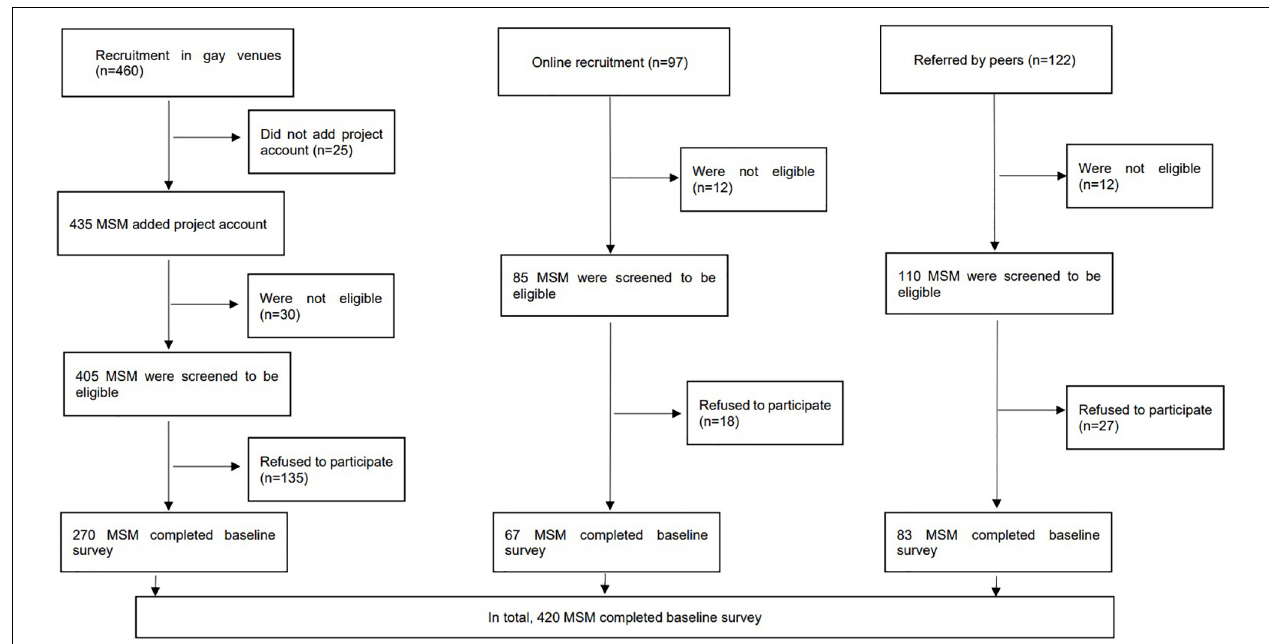
FIGURE 1 | Flowchart of the